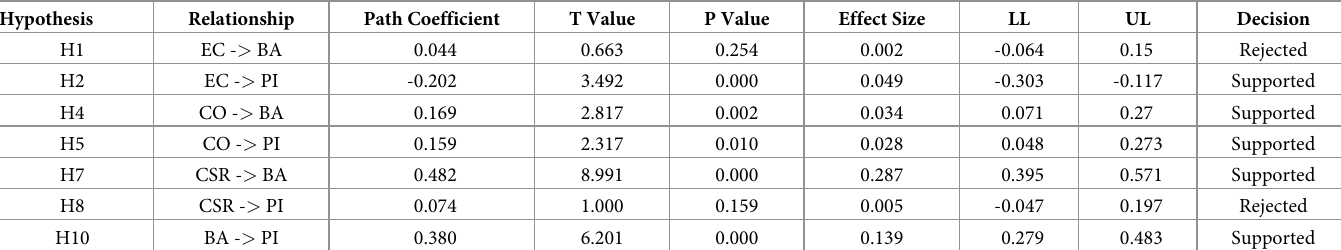
Table 6. Path coefficient.